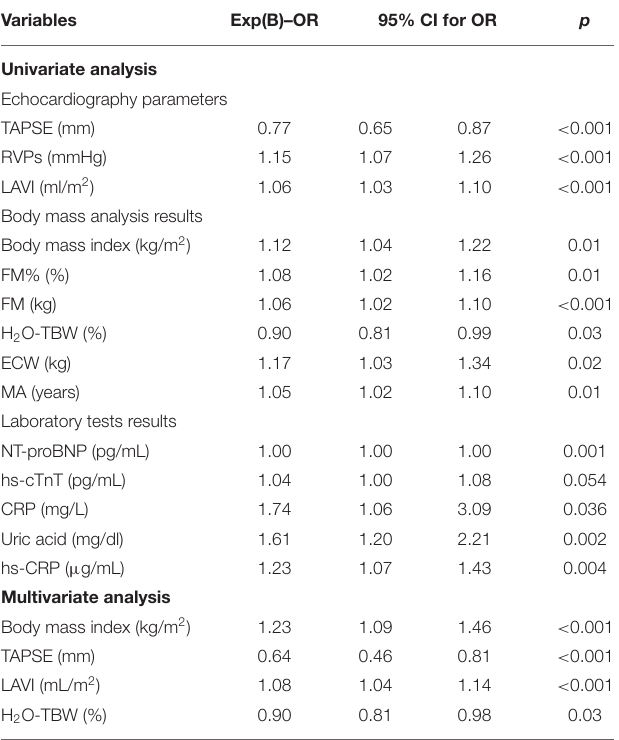
TABLE 7 | Univariate and multivariate analyses of association of patient characteristics with the occurrence of AF before PS matching. Variables Univariate analysis